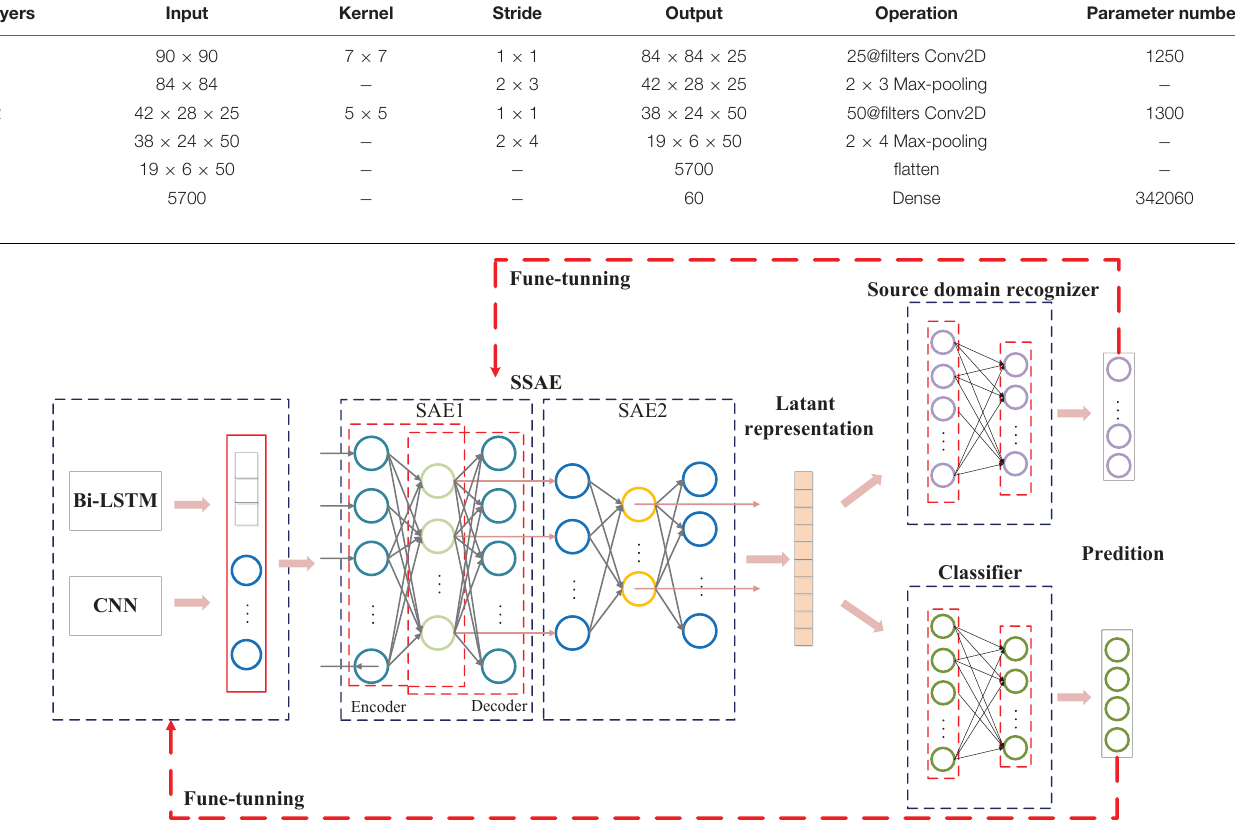
FIGURE 4 | The proposed domain-adversarial network architecture for exploiting invariance. Domain discriminant model and class identification model are both trained based on the reconstructed features. The difference is domain discriminant model try to obtain the invariant features cross-session or cross-subject while class identification model try to capture the discriminative information for